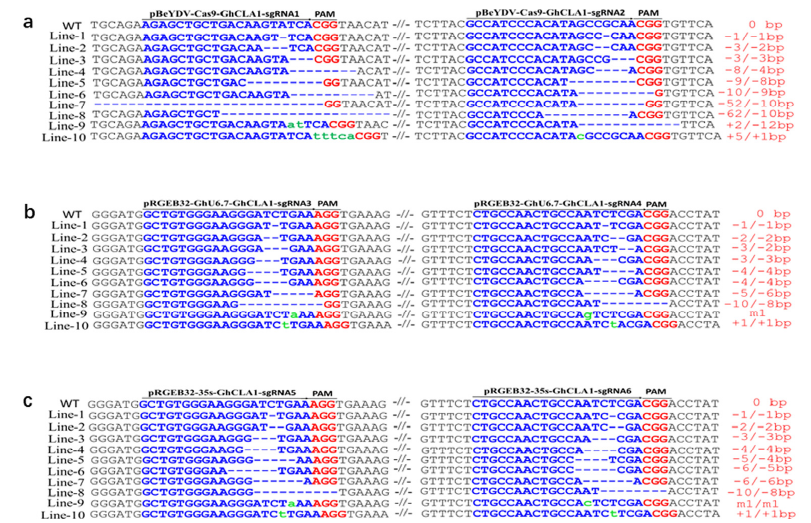
Figure 3. Comparison target mutation sequences of T0 plants edited by three vectors. ( a ): The target mutation profiles of T0 plants edited by pBeYDV-Cas9-GhCLA1. ( b ): The target mutation profiles of T0 plants edited by pRGEB32-GhU6.7-GhCLA1. ( c ): The target mutation profiles of T0 plants edited by pRGEB32-35S-GhCLA1.